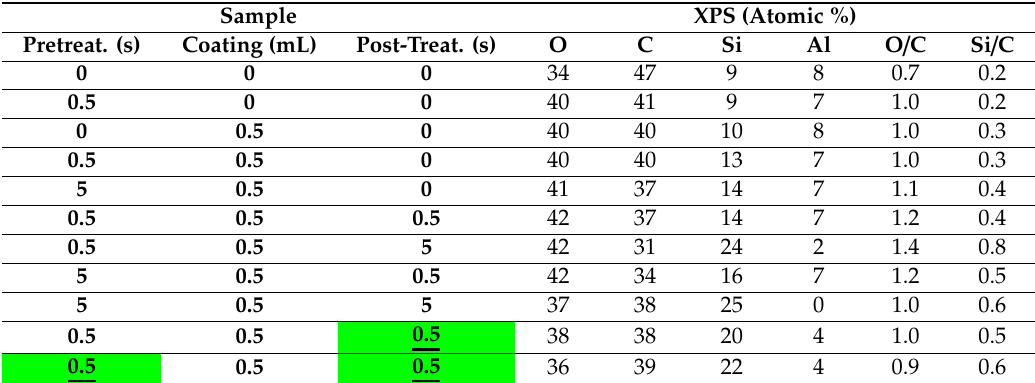
Table 3. Chemical composition of paper samples measured by XPS (treatment in nitrogen underlined and labeled